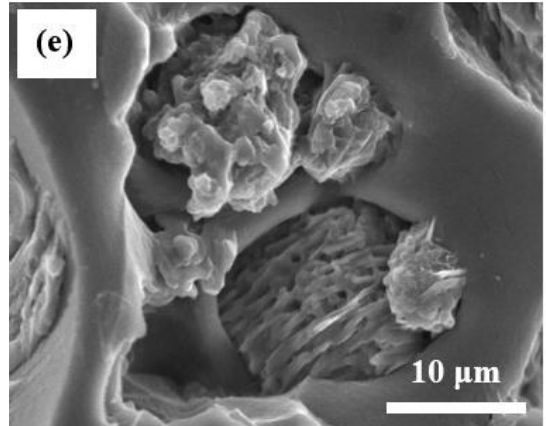
Figure 1. FESEM images of: ( a ) PVA hydrogel, ( b ) oil palm bio-waste (OPB)/PVA hydrogel, ( c )